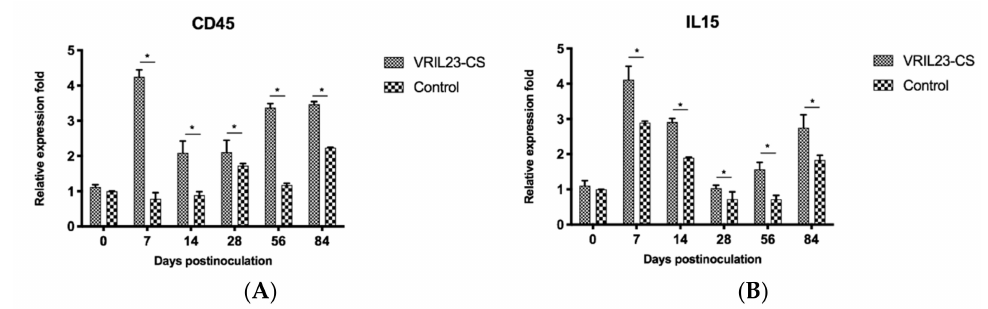
Figure 11. Gene expression levels of CD45 and IL15 in immune cells of the blood of experimental pigs.